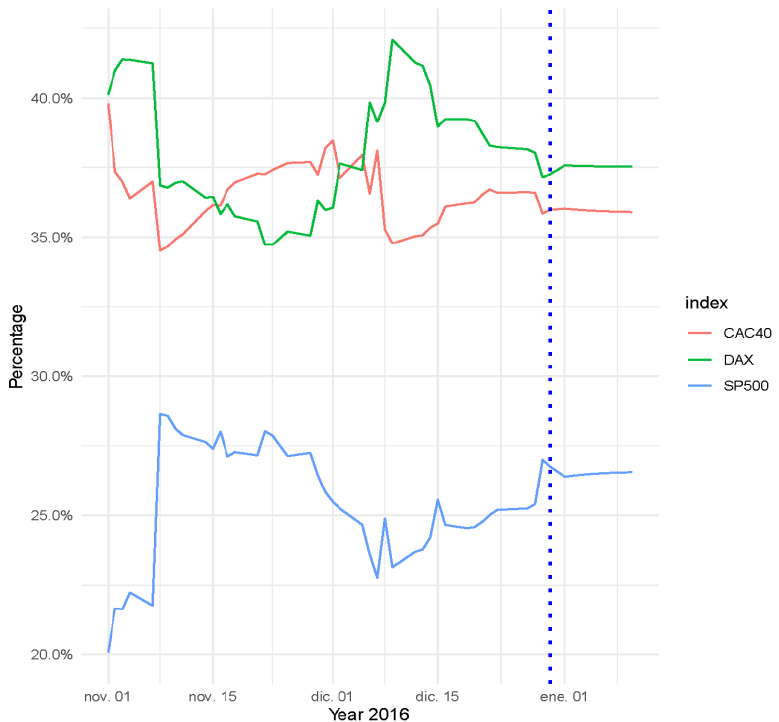
Figure 4. 10-days-ahead covariance capital allocation predictions: observed period from 1 November to 31 December 2016.